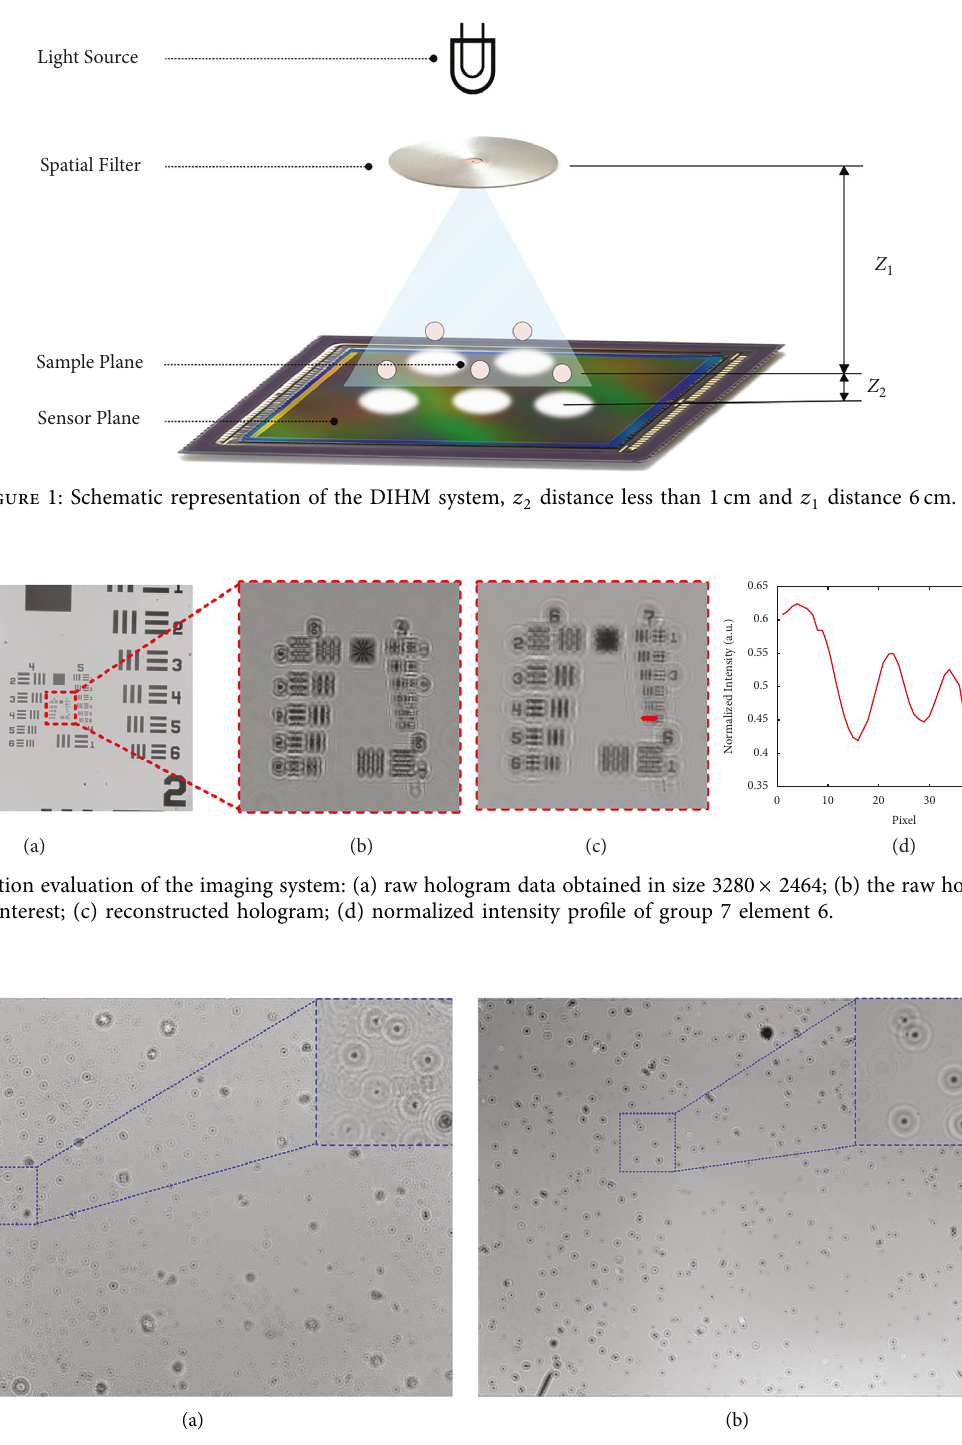
Figure 3: Medical samples were obtained with DIHM. (a) Image of human blood cells and selected ROI. (b) MCF-7 cell line and selected